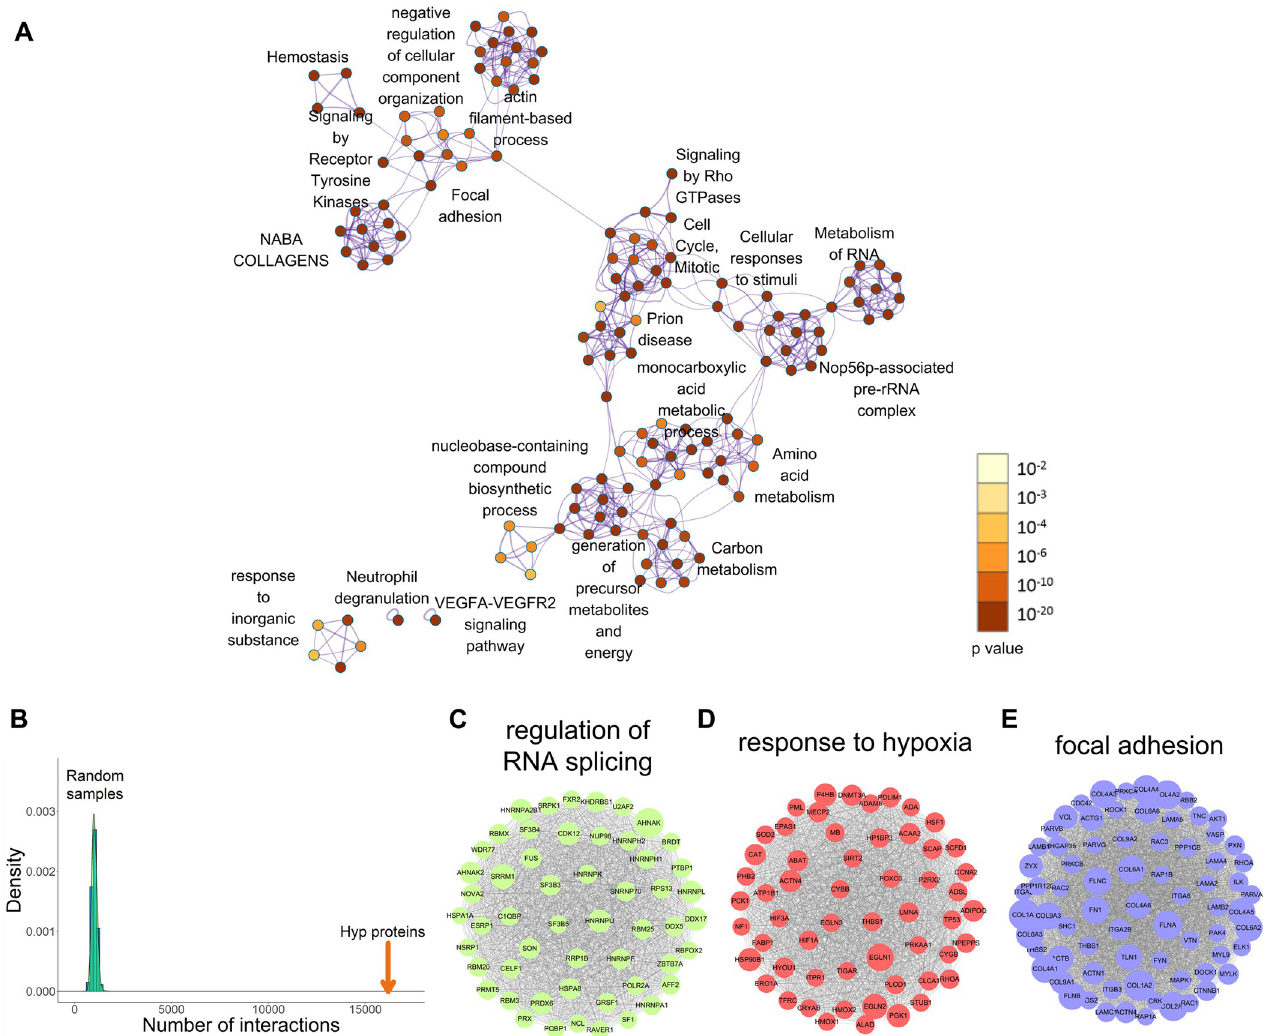
Fig 3. Gene enrichment and connectivity analysis of HypDB. (A) Interaction network of top 20 enriched functional annotation clusters of HypDB proteins. (B) Bootstrapping-based analysis of hydroxyproline protein interactions comparing to a distribution of protein interactions from random samples with the same number of human proteins. (C) Hydroxyproline proteins enriched in the regulation of RNA splicing. (D) Hydroxyproline proteins enriched in the response to hypoxia. (E) Hydroxyproline proteins enriched in focal adhesion. Refer to Sheet A in S4 Table, Sheet D in S2 Table, and Sheet B in S4 Table for the underlying data of Fig